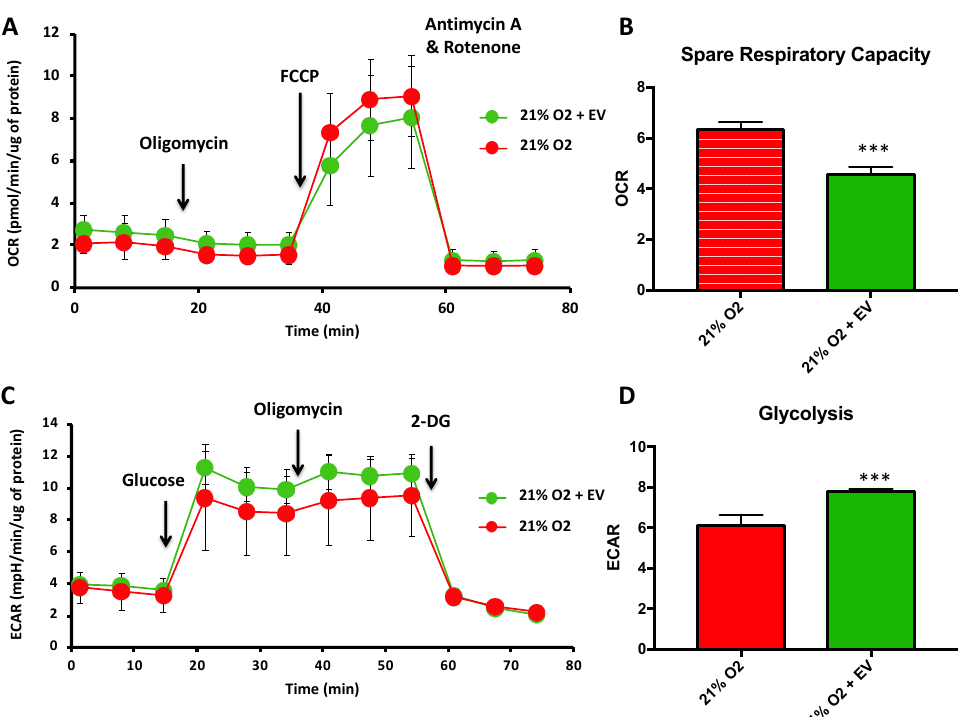
Figure 3. EV reduce mitochondrial oxidative respiration and increase mitochondrial glycolytic activity in premature senescent cells. ( A ) Normalized OCR and ( B ) OCR rates for spare respiratory capacity; ( C ) normalized ECAR and ( D ) ECAR rates for glycolysis in hDPSCs with or without 48 h incubation with EVs derived from young hDPSCs at passage 5, cultured at 3% O 2 . The data are shown as means ± SD ( n = 45). Statistical significance is expressed as *** p <